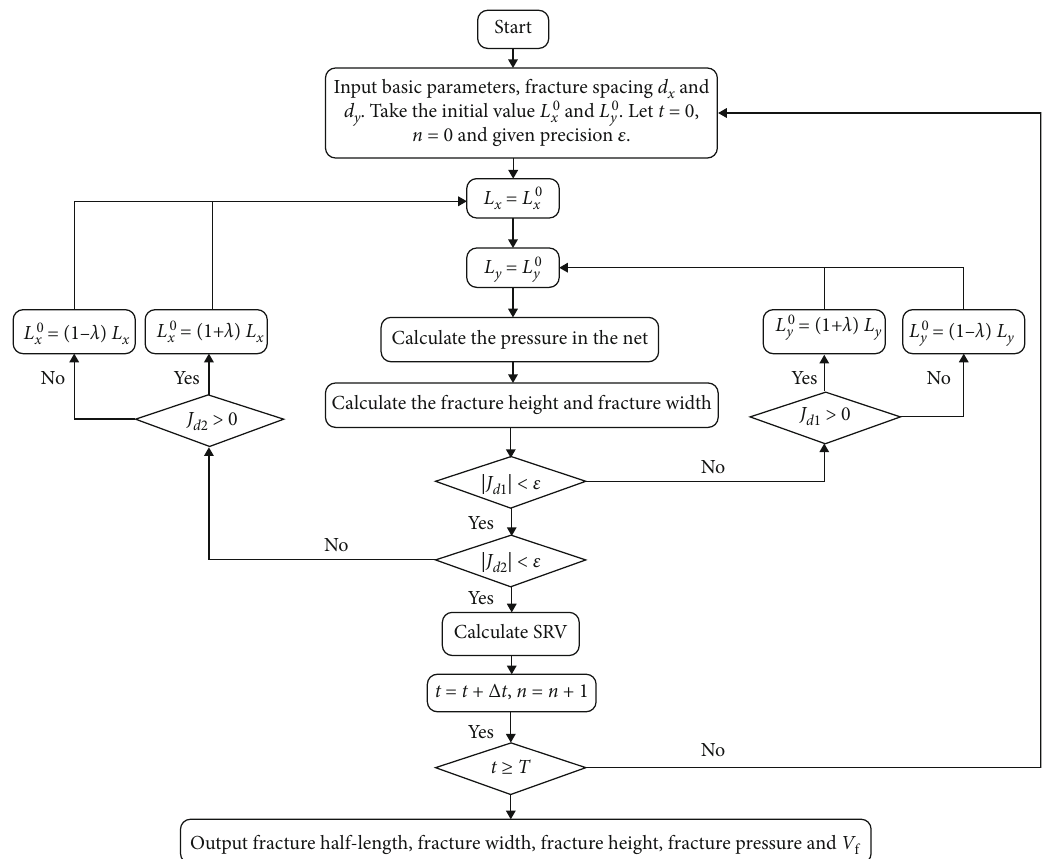
Figure 5: Flow chart of the forward algorithm for numerical